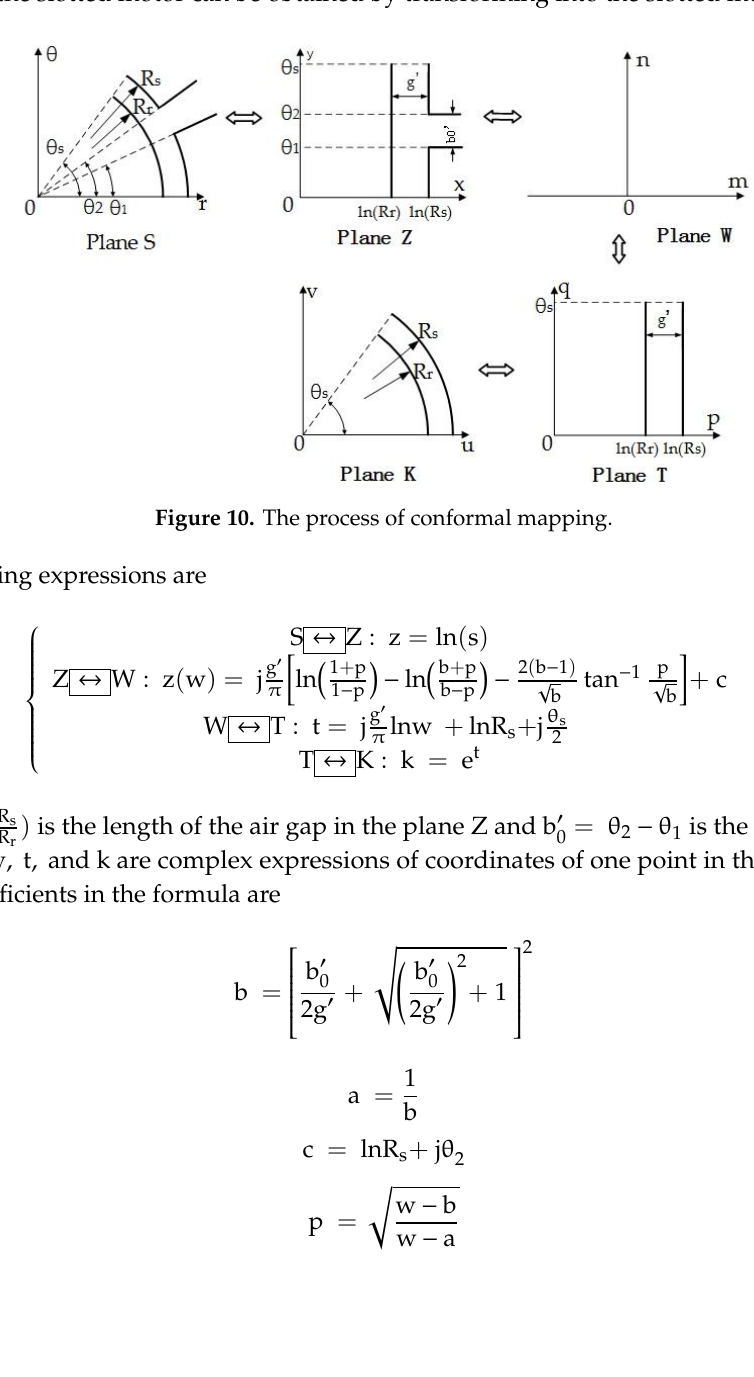
Figure 9. Comparison of the tangential component of magnetic field.